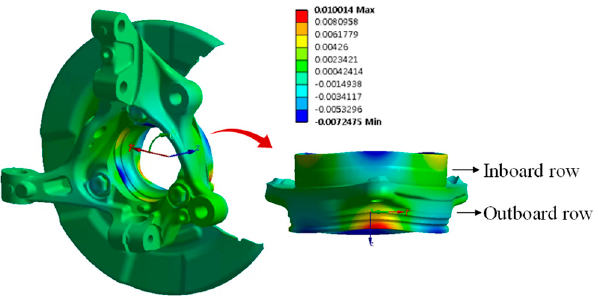
Figure 11. Analysis for the radial deformation of the assembled wheel bearing.